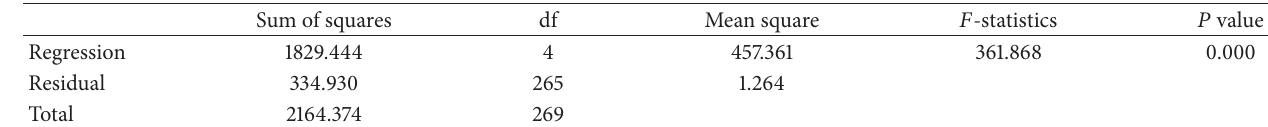
Table 5: The model fit values.